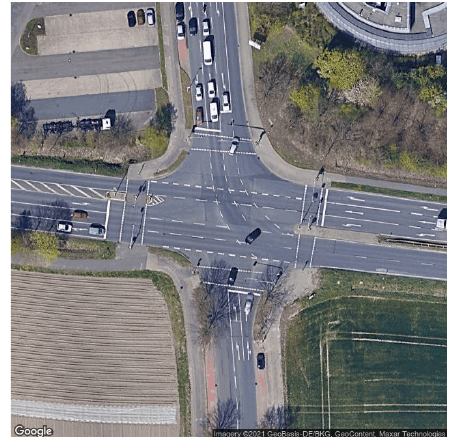
Figure 1. Example of an intersection with four arms from Google satellite